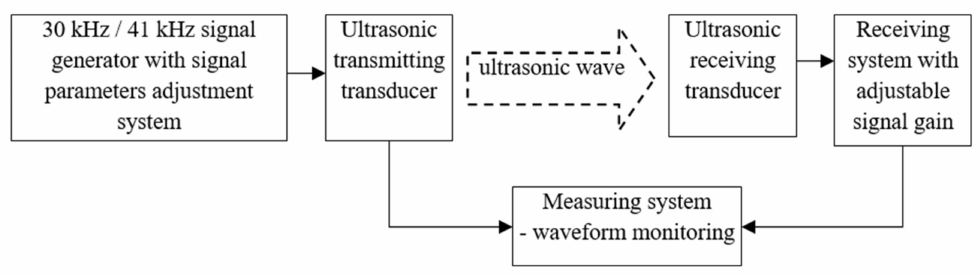
Figure 8. The test setup block